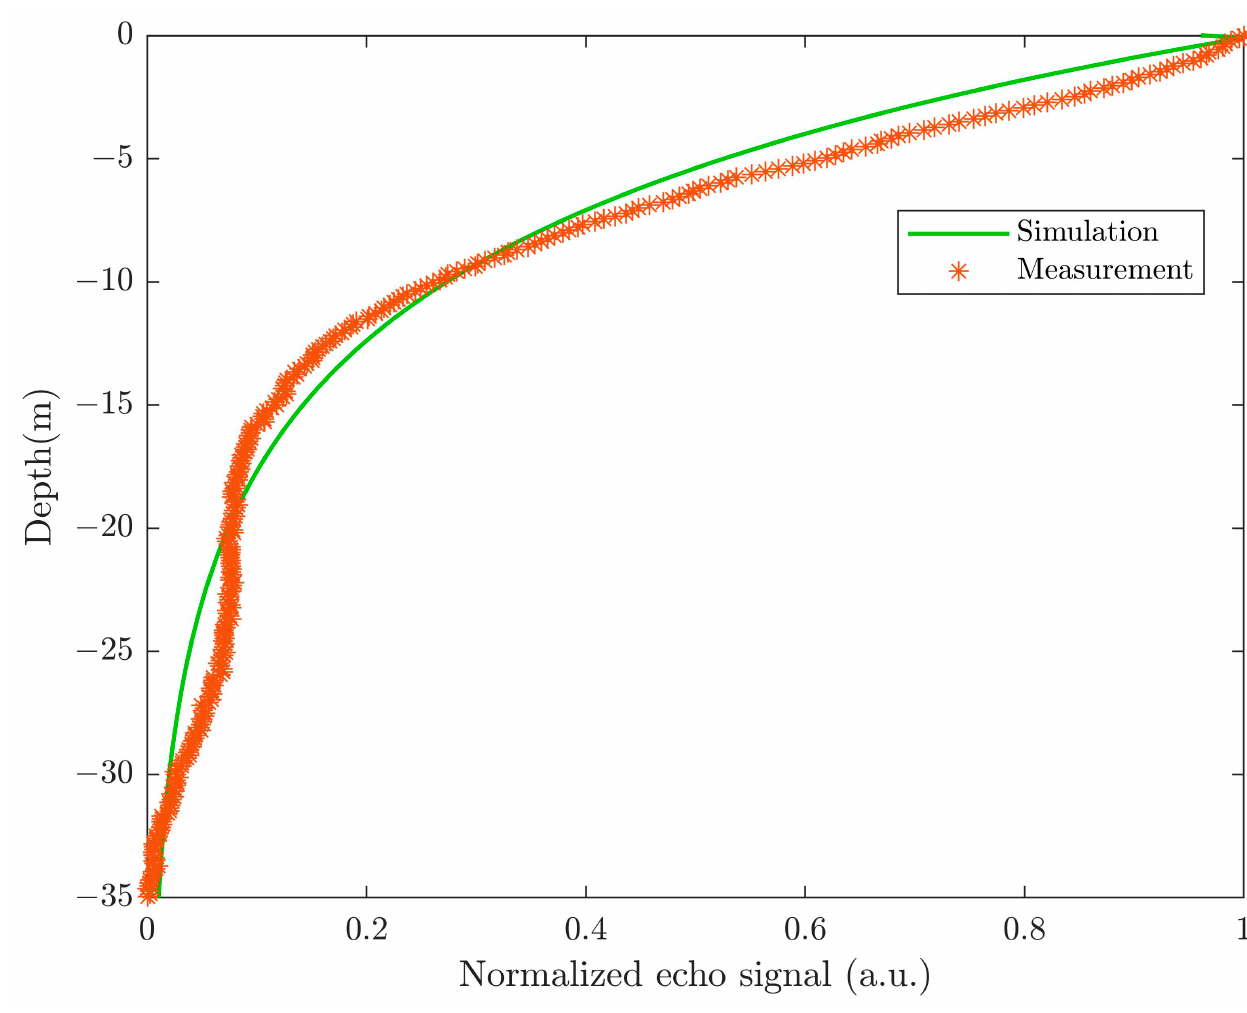
Figure 8. Comparison between simulation and in situ measurement.